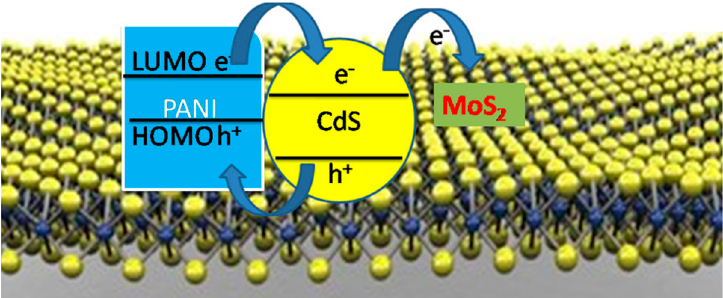
Figure 4. A proposed mechanism for the electron transfer of MoS 2 -PANI-CdS photocatalysts when illuminated. Figure adapted from [ 69 ].